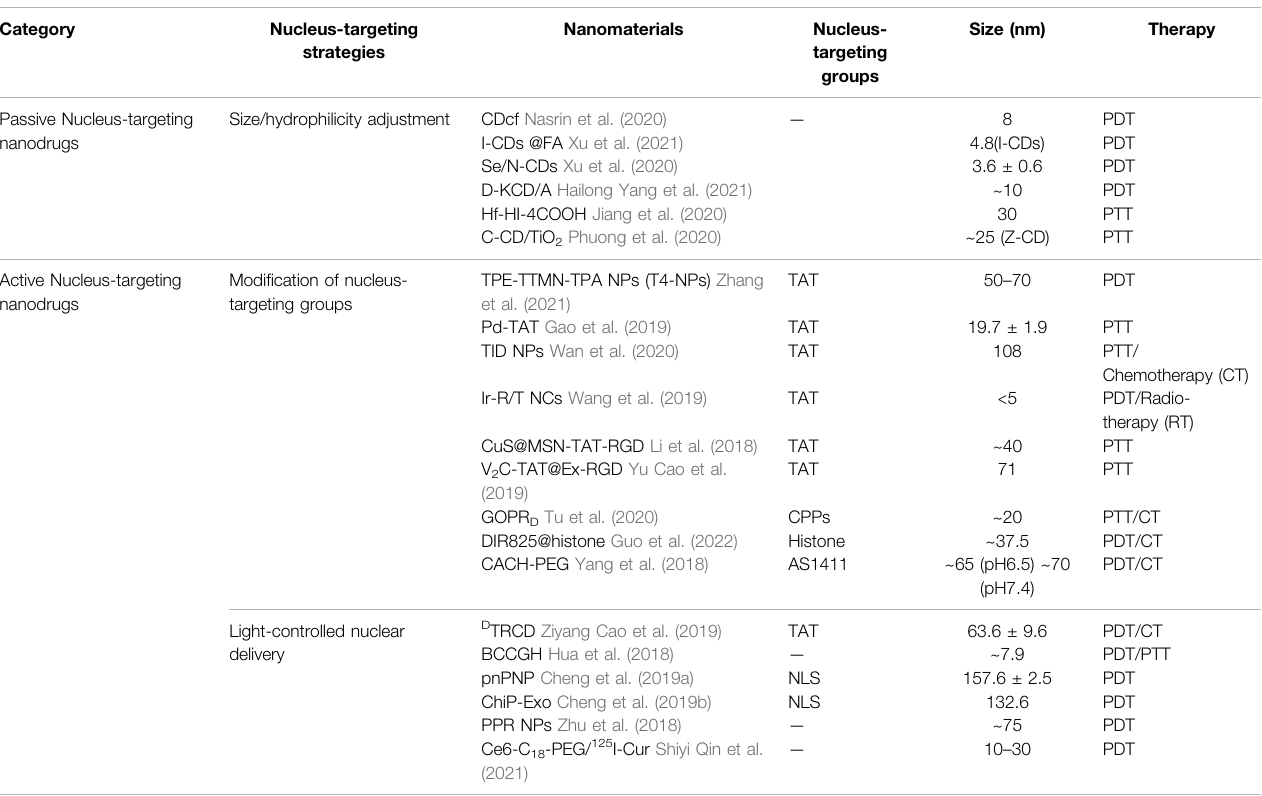
TABLE 1 | Nucleus-targeting nanodrugs for enhancing PDT and